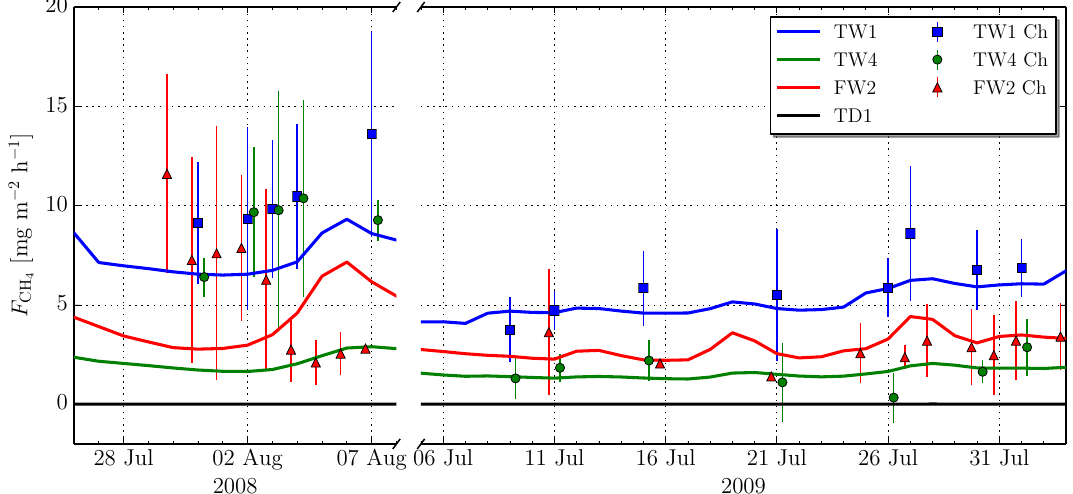
Figure 7. Temporal dynamics of the methane fluxes modelled with PEATLAND-VU and measured with the closed-chamber method for the EC measurement periods in 2008 and 2009. The chamber measurements of TW4 class are shifted 6h forward and FW2 class 6h backward for clearer indication of the error bars. TW1 is the Eriophorum angustifolium and Carex sp. and Arctophila fulva and Arctagrostis latifolia class, TW4 is the Sphagnum sp. class, and FW2 is the Arctophila fulva and Arctagrostis latifolia class, located on the